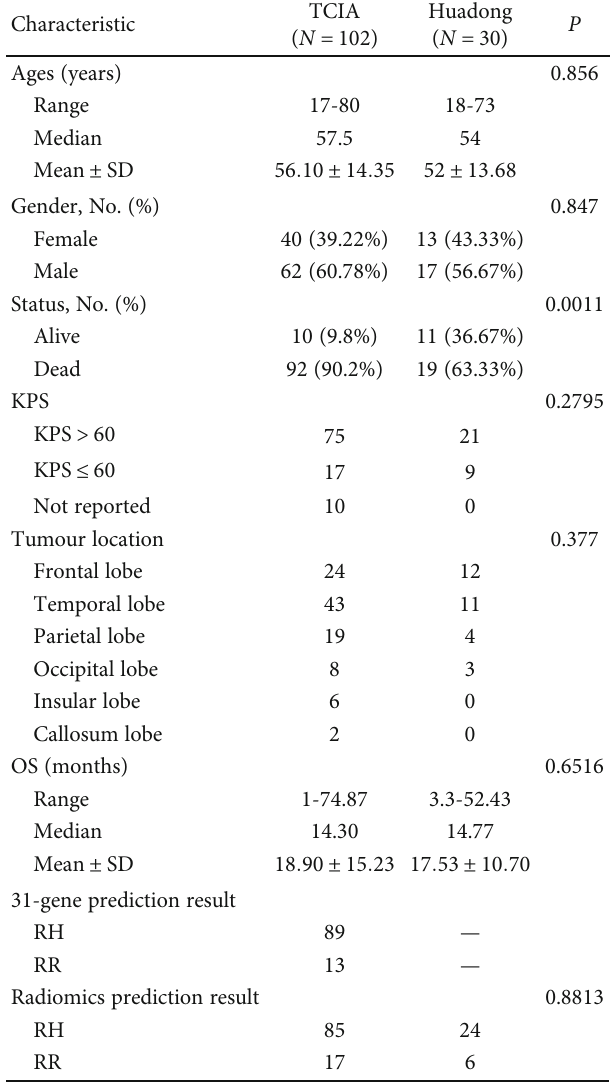
Table 1: Characteristics of patients in the TCIA and independent test